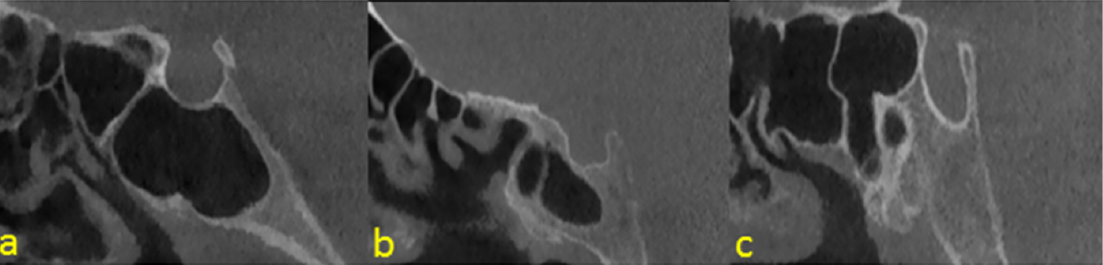
Figure 1. Examples of sella shapes: ( a ) round; ( b ) flattened; ( c )